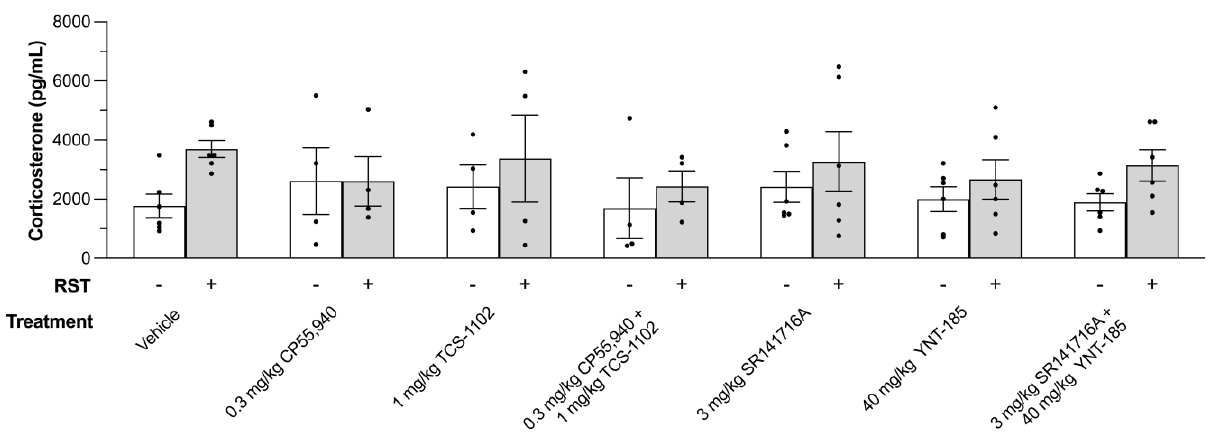
Figure 4. The effect of cannabinoid and orexin drugs on plasma corticosterone levels of mice that underwent the SPT and 24 h RST. After the final sucrose preference measurement on day 8, adult male and female C57BL/6 mice were euthanized, and their blood was collected for quantification of the circulating corticosterone using an ELISA kit. Data from 200 µL vehicle, 0.3 mg/kg CP55,940 (cannabinoid receptor agonist), 1 mg/kg TCS-1102 (DORA), 0.3 mg/kg CP55, 940 + 1 mg/kg TCS- 1102, 3 mg/kg SR141716A (CB1R antagonist), 40 mg/kg YNT-185 (OX2R agonist), and 3 mg/kg SR141716A + 40 mg/kg YNT-185-treated mice are expressed as pg/mL. n = 6 mice ( n = 3 males, n = 3 females) for Vehicle, 3 mg/kg SR141716A, 40 mg/kg YNT-185, and 3 mg/kg SR141716A + 40 mg/kg YNT-185 treatment groups. n = 4 mice ( n = 2 males, n = 2 females) for 0.3 mg/kg CP55,940, 1 mg/kg TCS-1102, 0.3 mg/kg CP55,940 + 1 mg/kg TCS-1102 treatment groups. Means ± SEMs were used to evaluate statistical significance by a two-way ANOVA foll owed by a Tukey’s post -hoc analysis. In the figure above “+” refers to with RST and “‒“ refers to without RST. 3.4. Cannabinoid – Orexin Receptor Colocalization in Male Brain Regions 3.4.1. CB1R-OX1R Colocalization Receptor colocalization measures the physical closeness or proximity of receptor pro- teins in a two-dimensional frame. Colocalization may therefore be indicative of potential interactions between receptors but does not provide direct evidence of heterodimerization [50]. In the current study, prolonged restraint stress along with drug treatments altered cannabinoid and orexin receptor colocalization levels within mesocorticolimbic regions involved in hedonic feeding [51]. Based on the SPT results (Figure 2), CB1R-OX1R/OX2R colocalization was quantified in the VTA, NAC, and MPFC of the vehicle, 3 mg/kg SR141716A, 40 mg/kg YNT-185, and 3 mg/kg SR141716A + 40 mg/kg YNT-185-treated male and female mice (Figures 5 – 8). In the VTA of male mice, 3 mg/kg SR141716A + 40 mg/kg YNT-185 led to greater CB1R-OX1R colocalization as compared to 3 mg/kg SR141716A and vehicle treatments in non-restraint samples ( p < 0.01) (Figure 5A). Within the 24 h RST groups, the combination of 3 mg/kg SR141716A + 40 mg/kg YNT-185 resulted in the most CB1R-OX1R colocalization amongst all other drug treatments ( p < 0.01 – 0.001) (Figure 5A). Similarly, in the male NAC, 3 mg/kg SR141716A + 40 mg/kg YNT-185 in- creased CB1R-OX1R colocalization relative to 40 mg/kg YNT-185, 3 mg/kg SR141716A, and vehicle-treated samples amongst the non-24 h RST groups ( p < 0.001) (Figure 5B). Within the 24 h RST groups, 3 mg/kg SR141716A + 40 mg/kg YNT-185 led to greater CB1R-